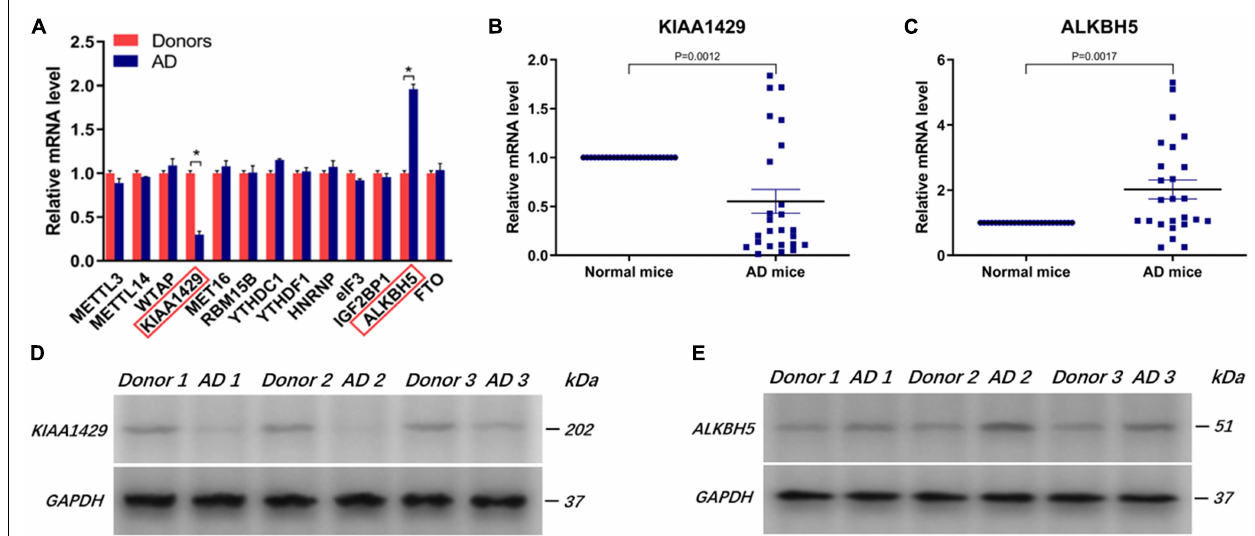
FIGURE 1 | KIAA1429 is downregulated while ALKBH5 is upregulated in aorta samples from AD patients. (A) KIAA1429 was significantly downregulated while ALKBH5 was upregulated in the aorta specimens of AD patients compared to donors. (B,C) The low expression of KIAA1429 or high expression of ALKBH5 was confirmed in 25 pairs of aortic tissues from normal and AngII-induced AD mice. (D,E) The protein levels of KIAA1429 and ALKBH5 in aorta specimens from AD patients were significantly lower and higher than in aorta tissues from donors, respectively. Data are presented as the mean ± SEM ( N ≥ 3 per group); * p < 0.05.